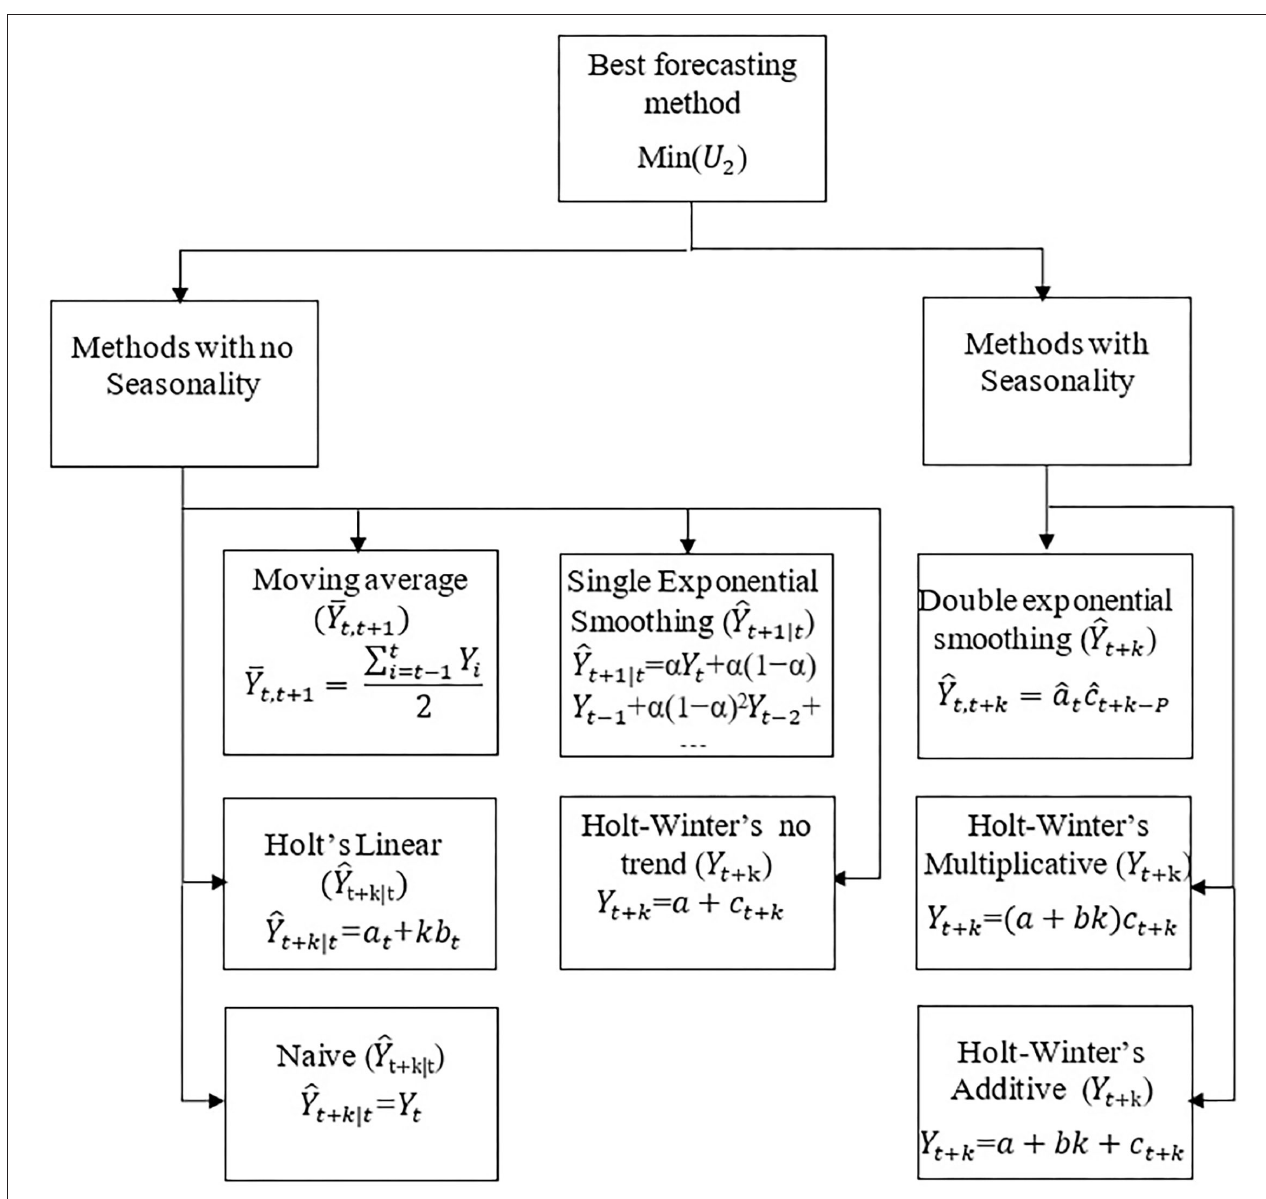
FIGURE 2 | Selection of appropriate forecasting